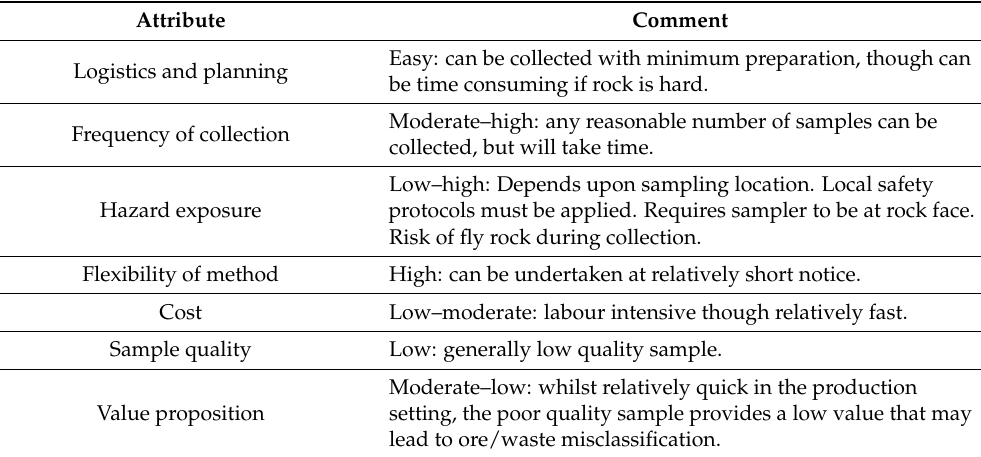
Figure 3. Orientation of linear samples (e.g., chip-channel) to match geological requirements. Sub-vertical quartz reef in foreground with area of flat veining on the footwall (blue line marks footwall contact). Sub-vertical reef sampled horizontally (samples 1 and 7), whereas flat footwall veins sampled vertically (samples 2–6). Table 8. Likely sampling errors during the collection of chip or chip-channel samples. Table 9. Chip sampling attributes for grade